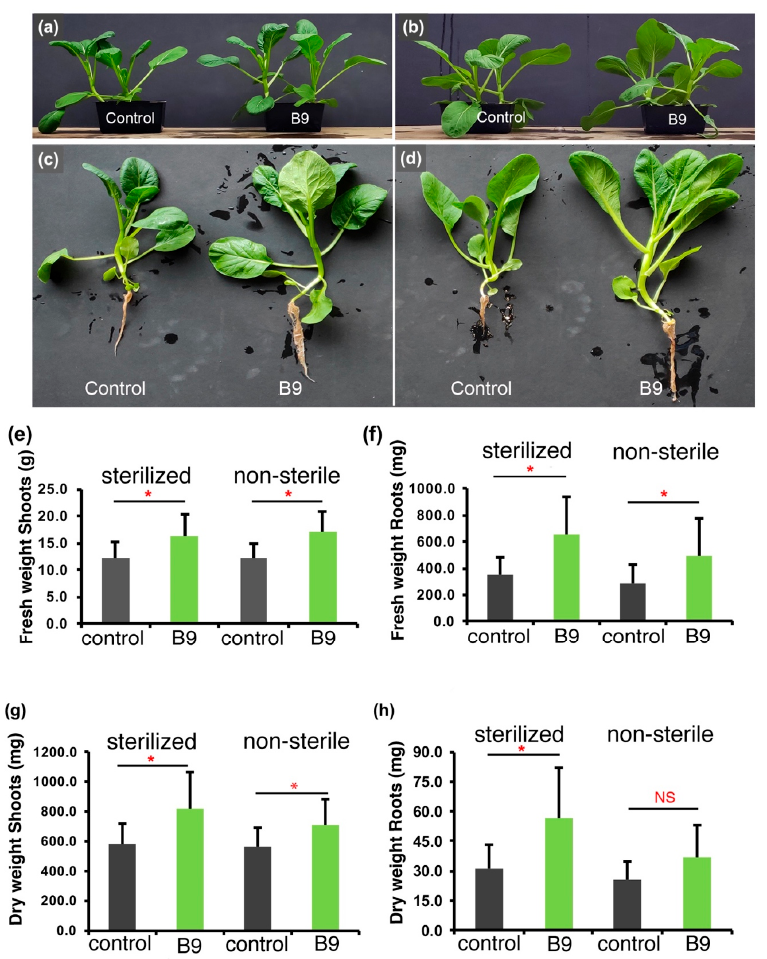
Figure 1. The morphological traits of Choy Sum inoculated with P. citrinum and the plant growth promotion e ff ect in sterilized or non-sterilized soil ( b , d ). ( a , c ) The morphological traits of Choy Sum grown for 21 days in autoclaved soil (left, water; right, inoculated with B9 conidia); ( b , d ) The mor- phology and growth characteristics of Choy Sum plants grown in non-autoclaved soil for 21 days (left, water; right, inoculated B9 spores). ( e – h ) Bar charts showing quanti fi cation of the fresh and dry weight of shoots/aerial parts ( e , g ) and roots ( f , h ) under the two growth conditions, respectively. Data represents means ± SDs from 3 replicates consisting of 16 plants in each instance. Di ff erences were considered signi fi cant at a probability level of p < 0.05 (*). NS: not signi fi cant.